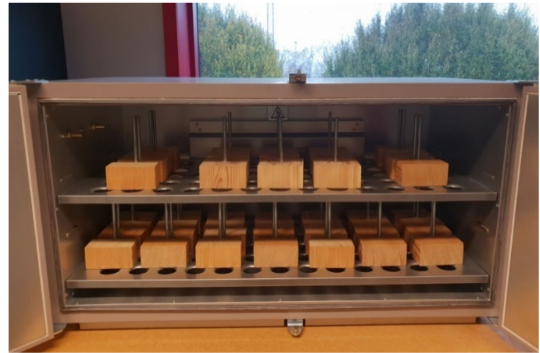
Figure 2. Preparation of specimens under controlled